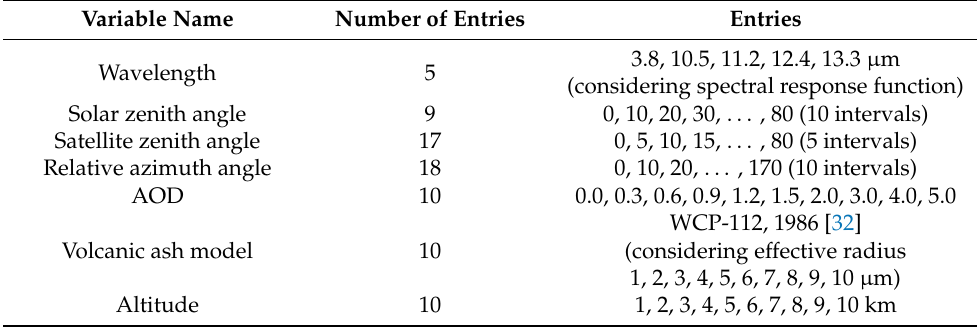
Table 2. List of the input variables used for the calculation of the volcanic ash aerosol optical depth (AOD) lookup